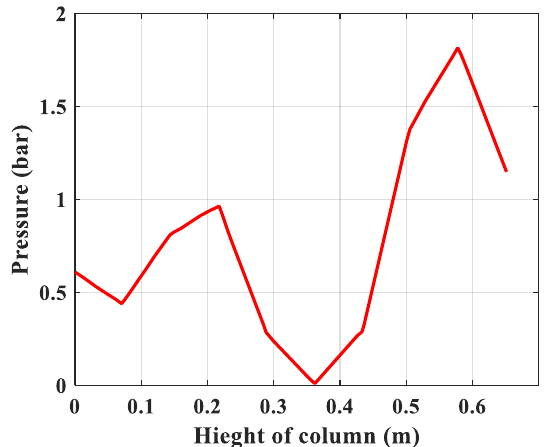
Figure 11. The result of partial pressure (O 2 ) following height of column at 8 bar.